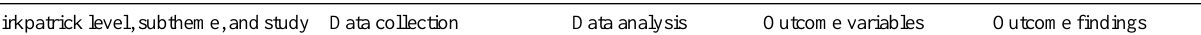
Table 1. Outcomes of MOOC studies framed by Kirkpatrick Level 2 or Level